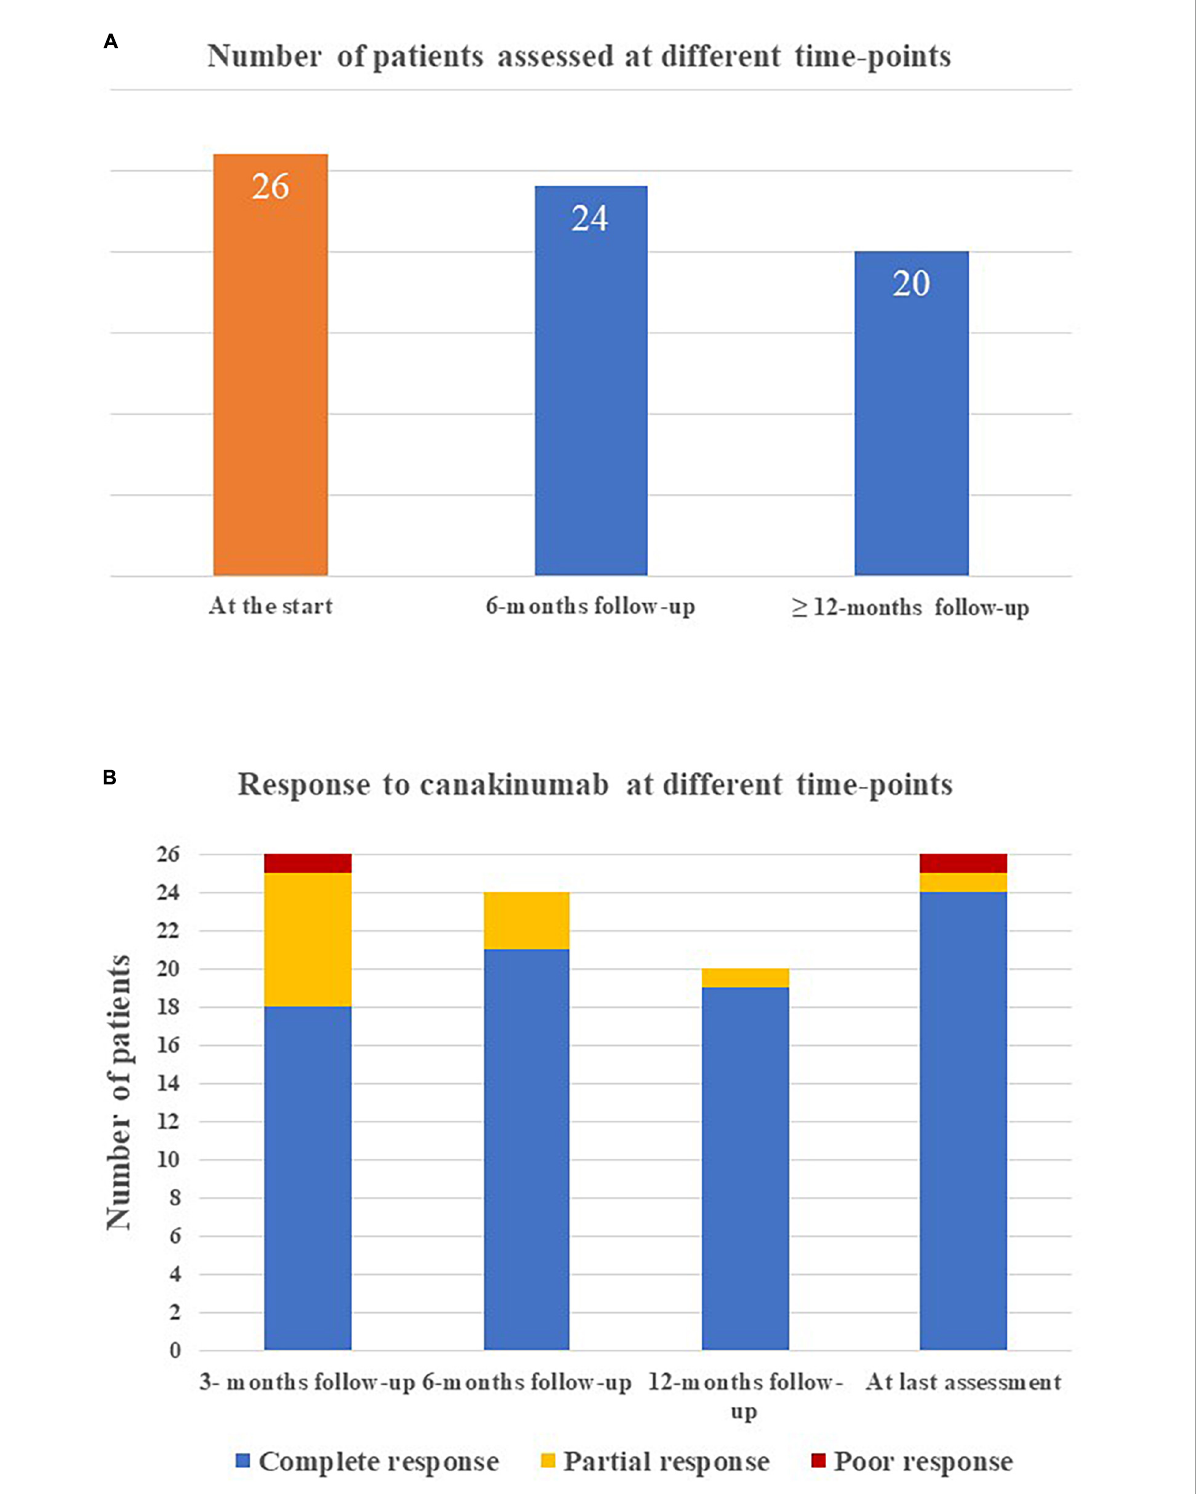
FIGURE3 Graphical representation of (A) the number of patients reaching the different time-points during follow-up while on canakinumab treatment; (B) the frequency of complete response, partial response, and poor response in the whole group of patients enrolled at the different